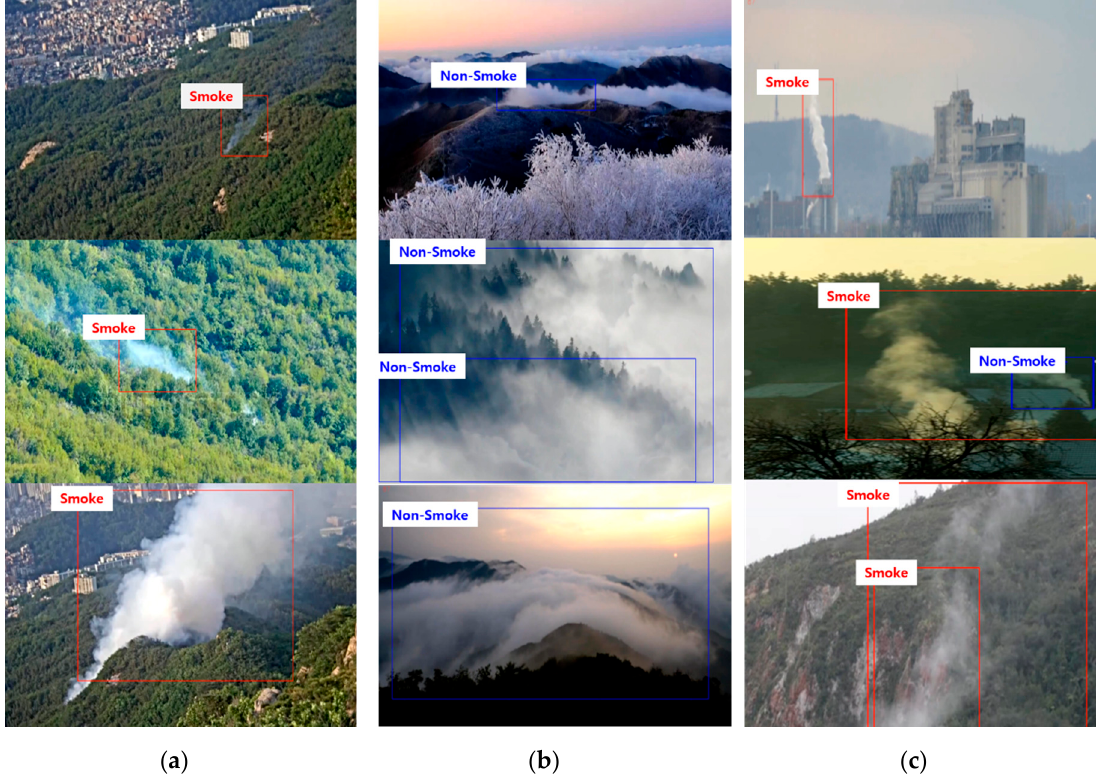
Figure 9. Wildfire smoke detection results using the proposed method: ( a ) Correctly detected smoke regions regardless of size, ( b ) correctly detected non-smoke regions such as clouds and fog, and ( c ) falsely detected smoke regions for chimney smoke and fog against a mountain background.